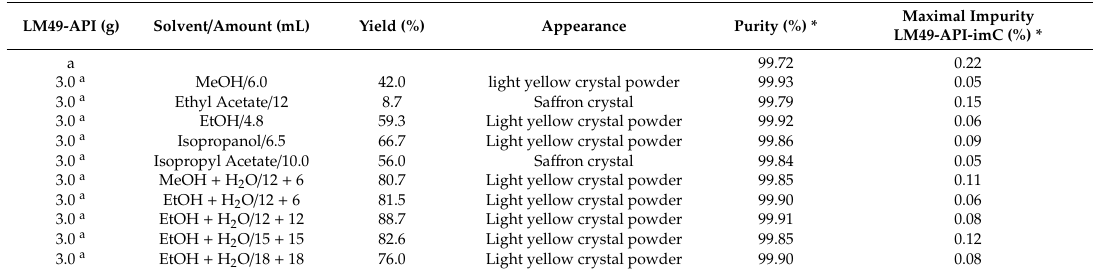
Table 6. Screening of purification conditions for LM49-API